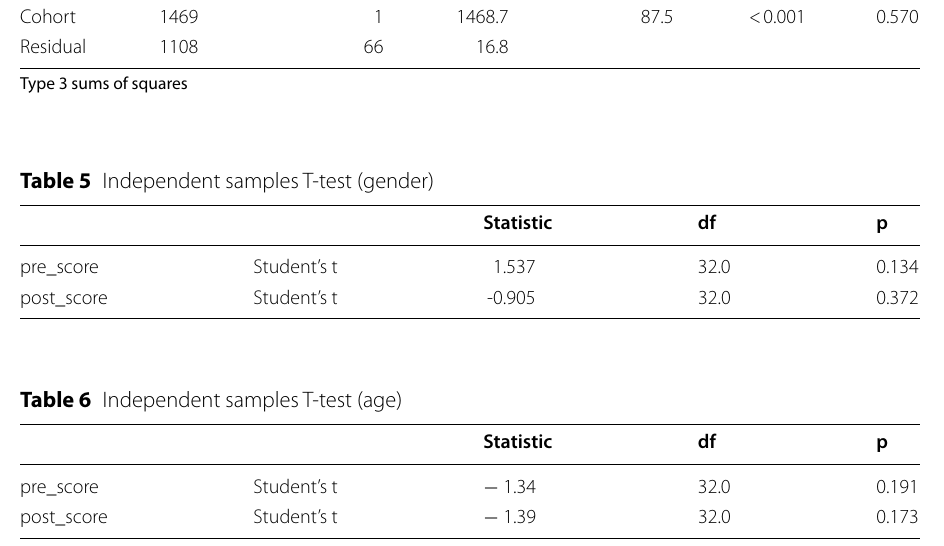
Table 4 Within‑subject effect (II)